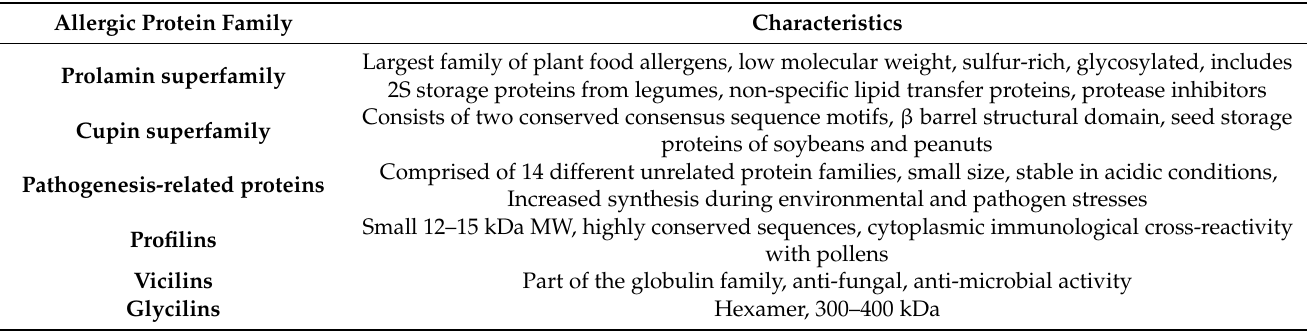
Table 7. Major allergic protein families of legumes and their significant characteristics. Allergic Protein Family